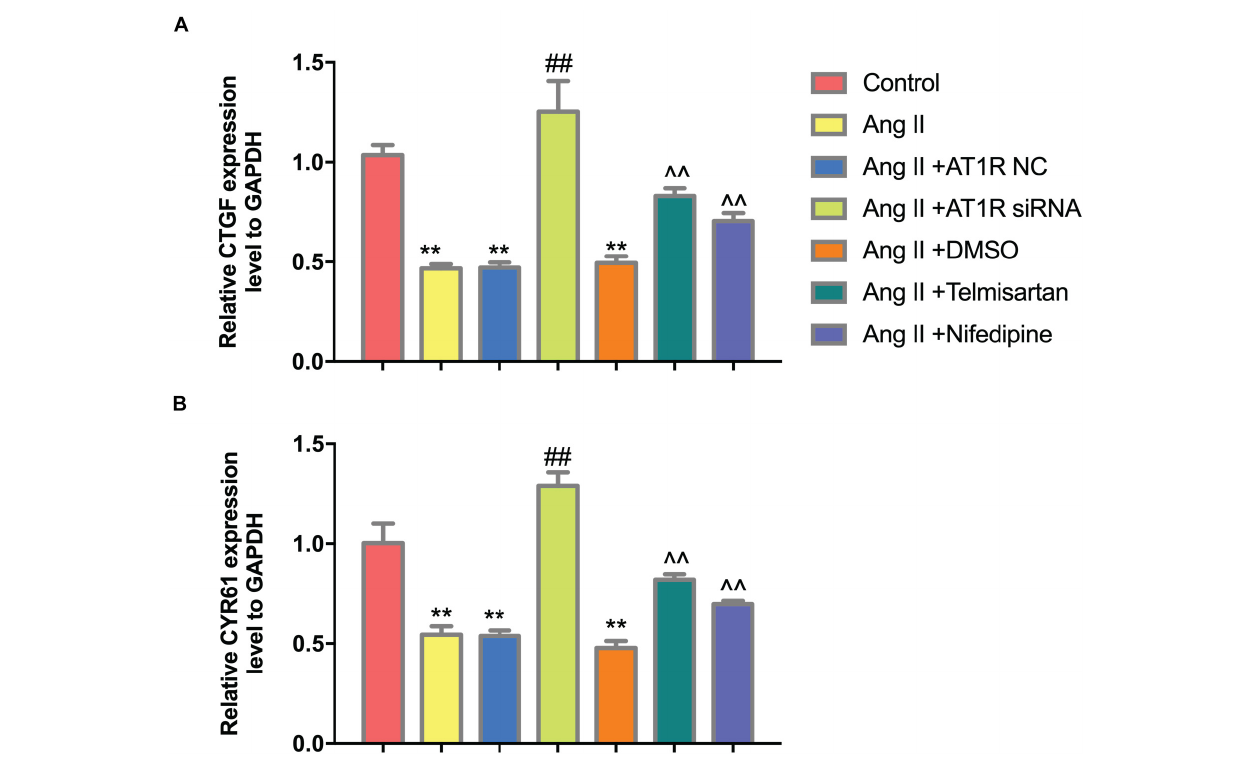
FIGURE 5 | Ang II can reduce the expression of CTGF and CYR61, while AT1R siRNA transfection and Telmisartan treatment can alleviate this effect. (A) The qRT-PCR results of CTGF in THP-1 from different group after 96 h co-culture; (B) The qRT-PCR results of CYR61 in THP-1 from different group after 96 h co-culture. ( n = 3, mean and S.D., t -test, ** P < 0.05 compared with the control group; ## P < 0.05 compared with the HAECs + THP-1 + Ang II group; ∧∧ P < 0.05 compared with the HAECs + THP-1 + Ang II + DMSO